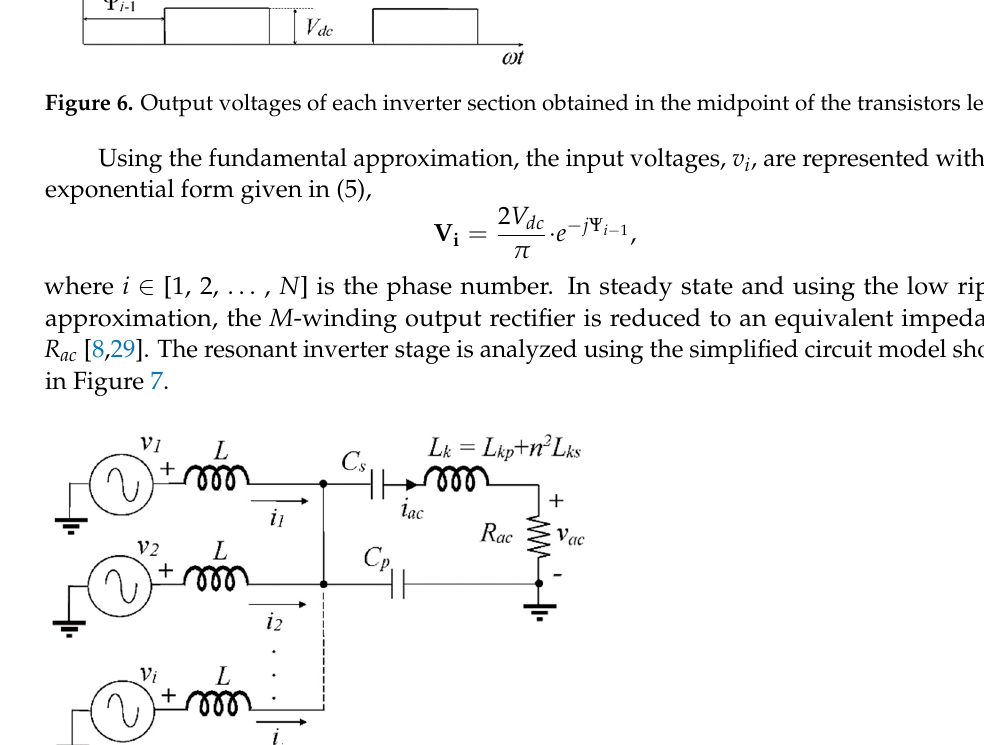
Table 1. Parameters of the LC p C s resonant inverter.